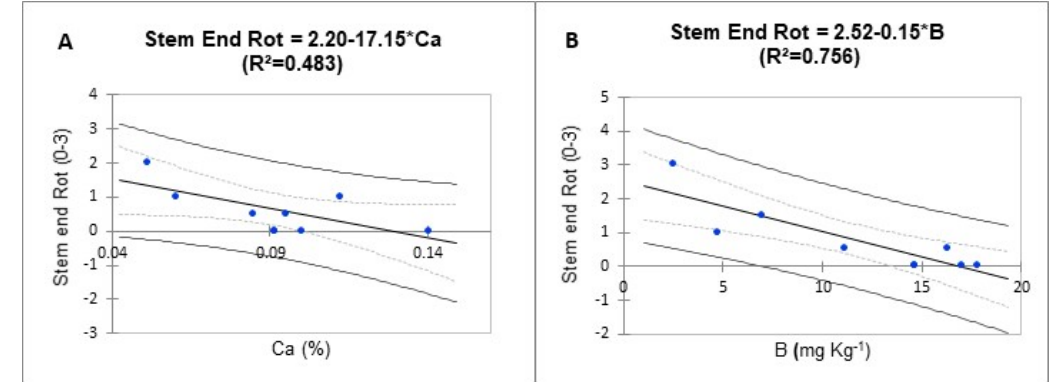
Figure 7. Mineral content and its relationship with Stem end Rot: ( A ) LE farm (DM-22, ST= 4 weeks); ( B ) LE farm (DM-26, ST= 5 weeks).